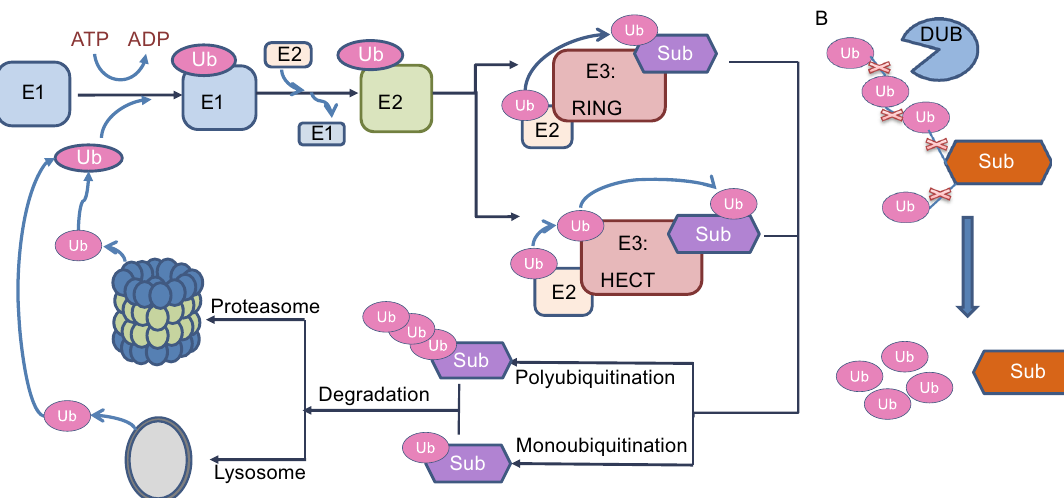
Figure 2. Protein ubiquitination and deubiquitination. (A) E1 starts the ubiquitination process along with ATP. The E1 enzyme passes the Ub protein to E2s. The E2s are then complex with Ub ligase E3s. In the fi nal step, E3s catalyze Ub transferring to substrates. Proteins can be ubiquitinated with multiple types including monoubiquitination and polyubiquitination, and degraded in the lysosome or the proteasome, respectively. (B) DUBs remove Ub molecules from